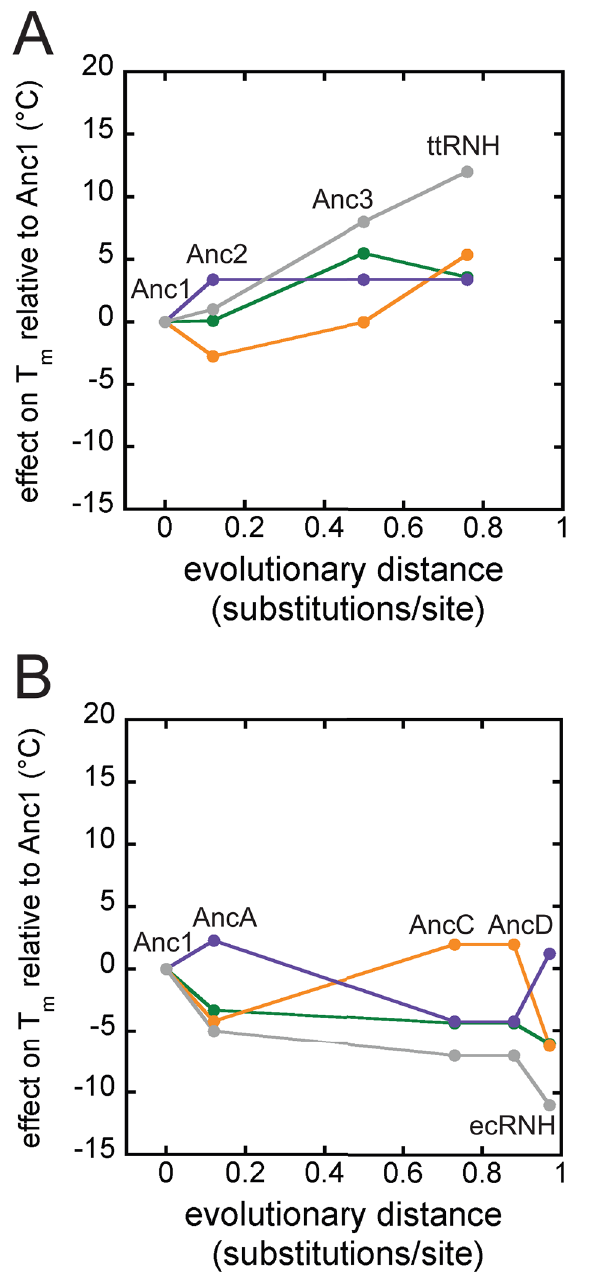
Figure 5. No single parameter dominates changes in thermo- stability along the RNH lineages. Figure shows the change in T m and contribution of each thermodynamic parameter to T m for the maximum likelihood evolutionary path. (A) How each thermodynamic parameter contributes to changes in T m along the thermophilic lineage. Total changes in T m (grey) represent the sum of contributions from D C p (orange), D H s (green), and D T s (purple). (B) How each thermodynamic parameter contributes to changes in T m along the mesophilic lineage. Colors are as in (A). See also Dataset S2. doi:10.1371/journal.pbio.1001994.g005 S8). Paths within the 95% confidence interval had lengths between 75% and 230% of the length of the most probable path. Even the shortest plausible path, at the very edge of the confidence interval, still exhibited dramatic fluctuations over evolutionary time (Figure 6).